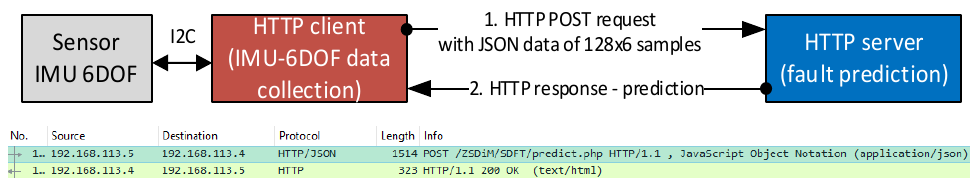
Figure 5. HTTP/1.1 request–response as batch processing of machine state prediction. Data from the application layer are encapsulated by lower layer headers. Figure 6